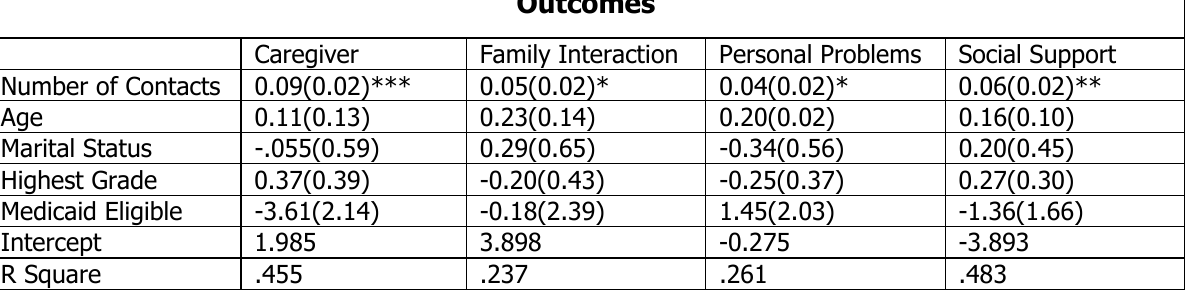
The unstandardized regression coefficients (Standard Error) for the association of caregiver, family interaction, personal problems affecting parenting, and social support characteristics with number of